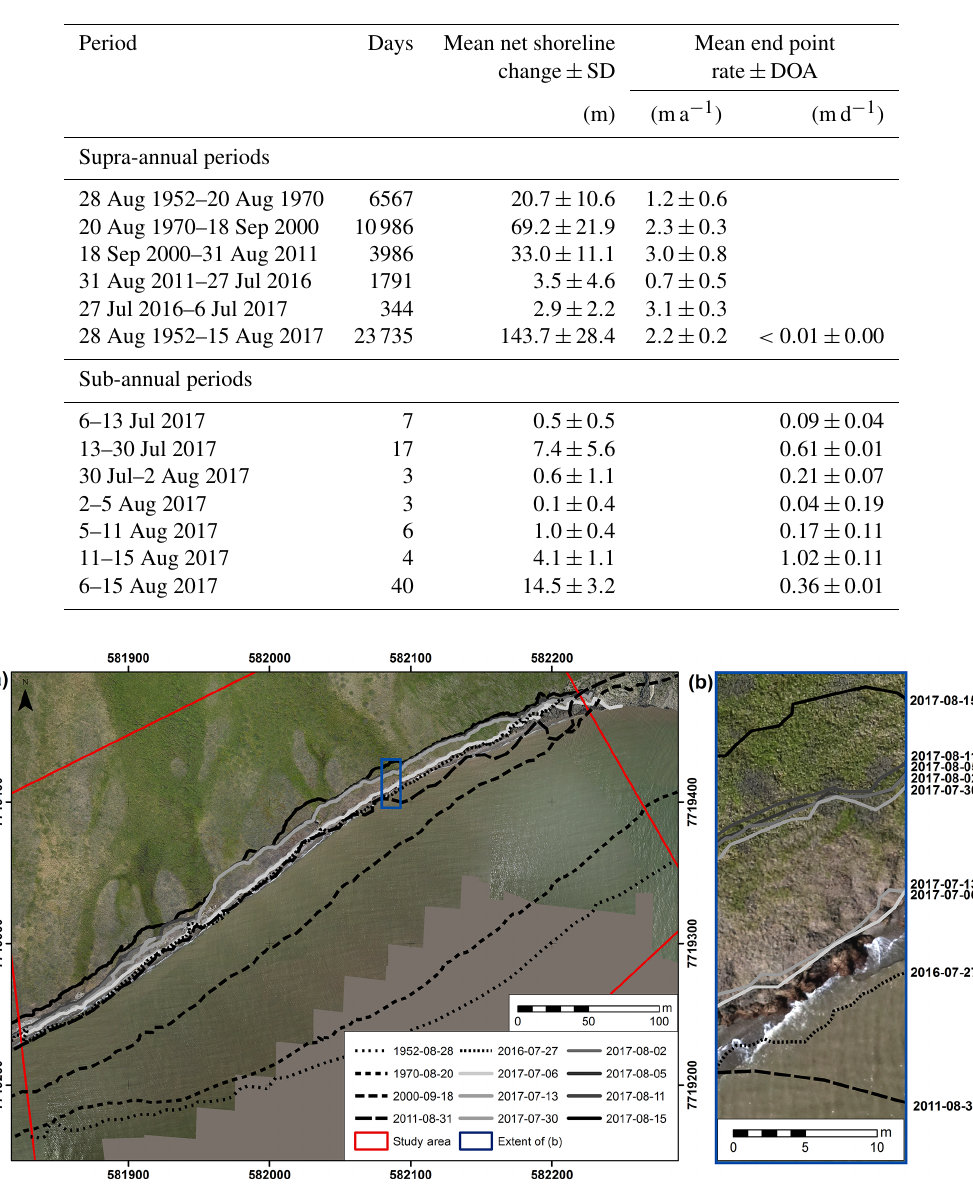
Table 2. Summary of shoreline change for all periods, in terms of net shoreline change and end point rates. Net shoreline change mean is the distance between the oldest and youngest shorelines, where SD is standard deviation. End point rate is the net shoreline change normalised by time (years or days, for supra- or sub-annual periods, respectively), where DOA is dilution of accuracy (after Eq. 2).